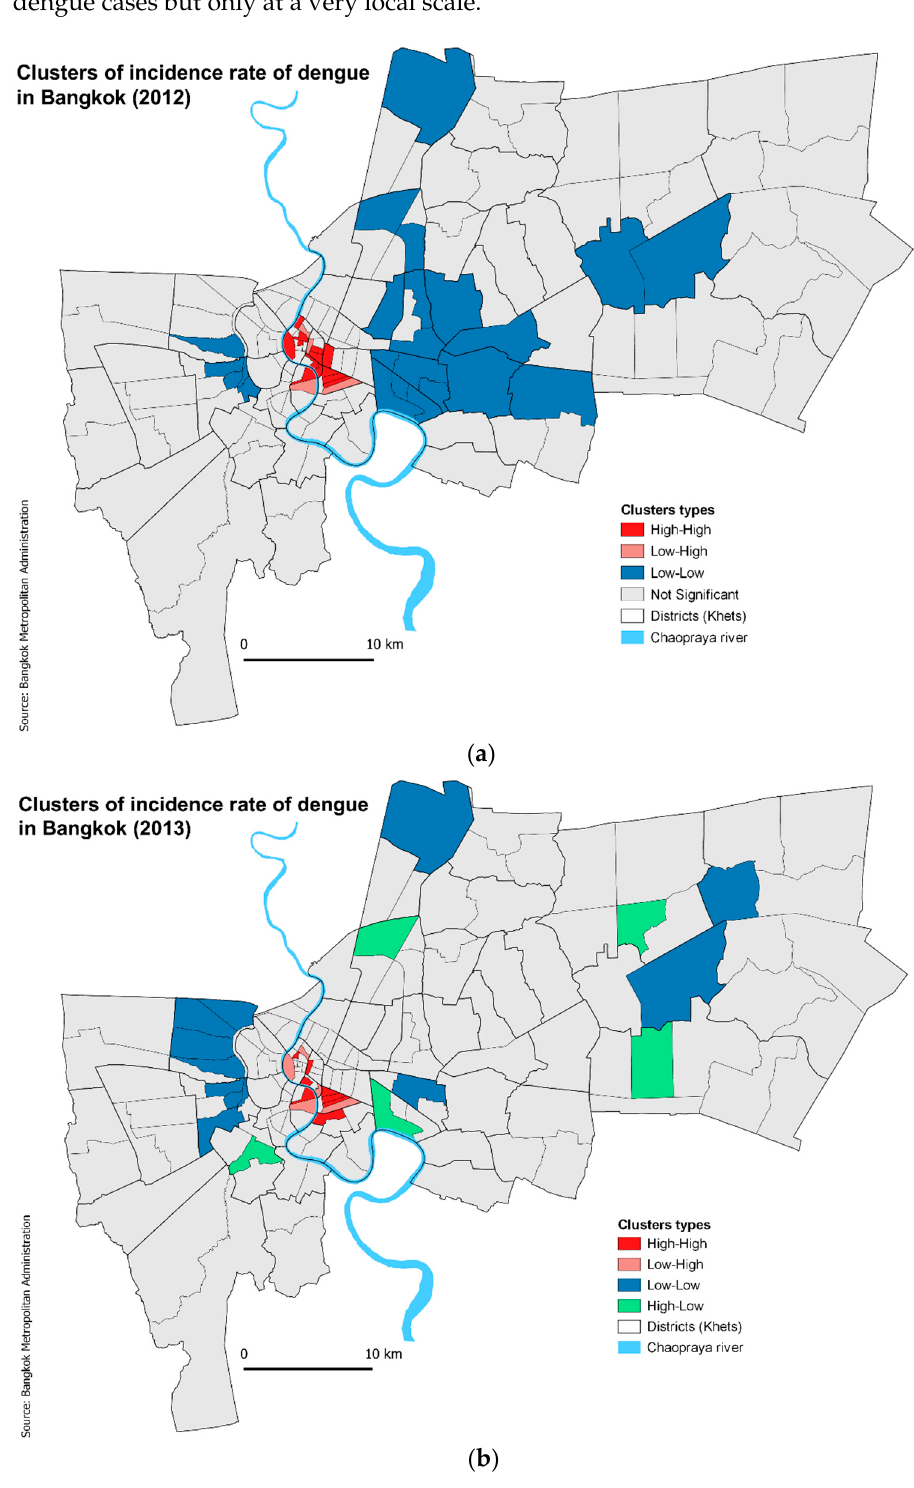
Figure 2. Cluster analysis of incidence rates of dengue across subdistricts in Bangkok, Thailand by year ( a ) 2012 and ( b ) 2013.